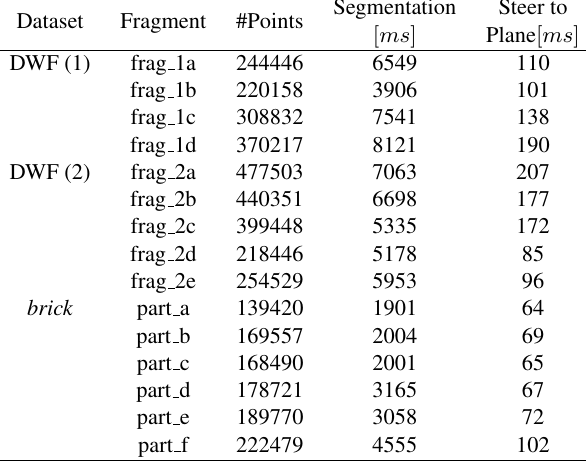
Table 2: Processing time for the starting setup.Time to load each